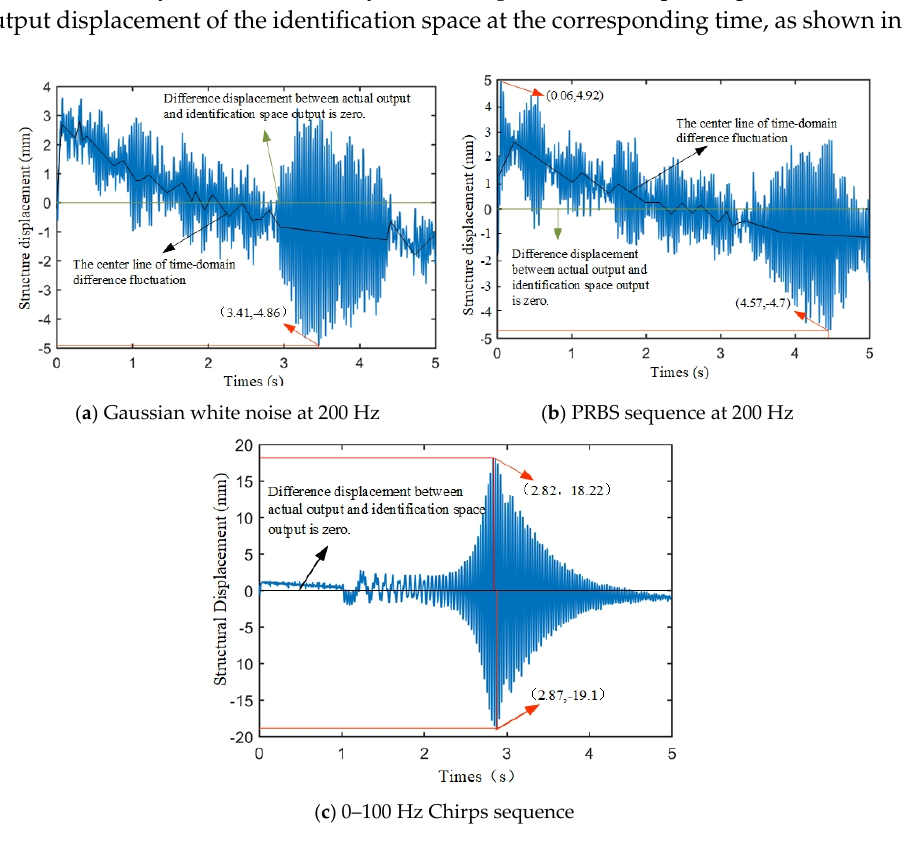
Figure 9. Displacement difference between actual output and identification space output.